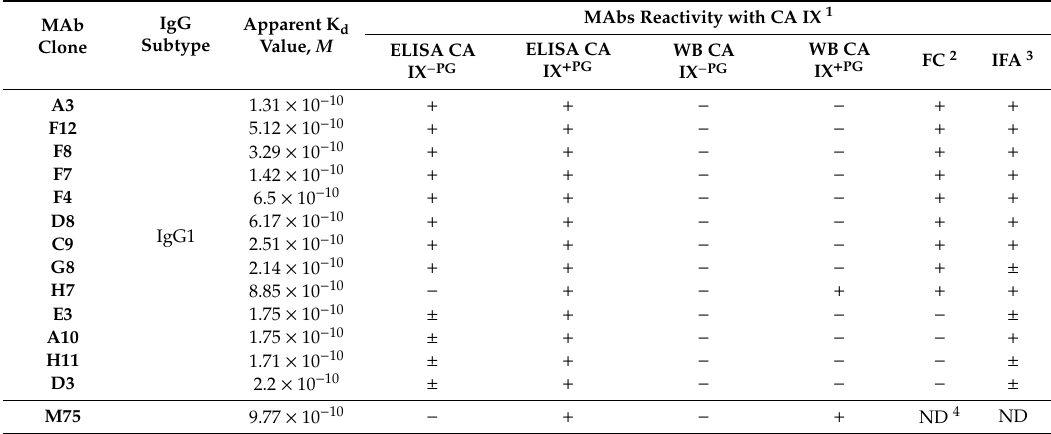
Table 2. Summarized characteristics of generated MAbs against recombinant CA